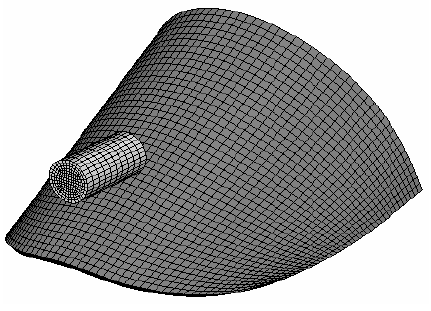
Fig. 7. FE model of windshield for bird strike.